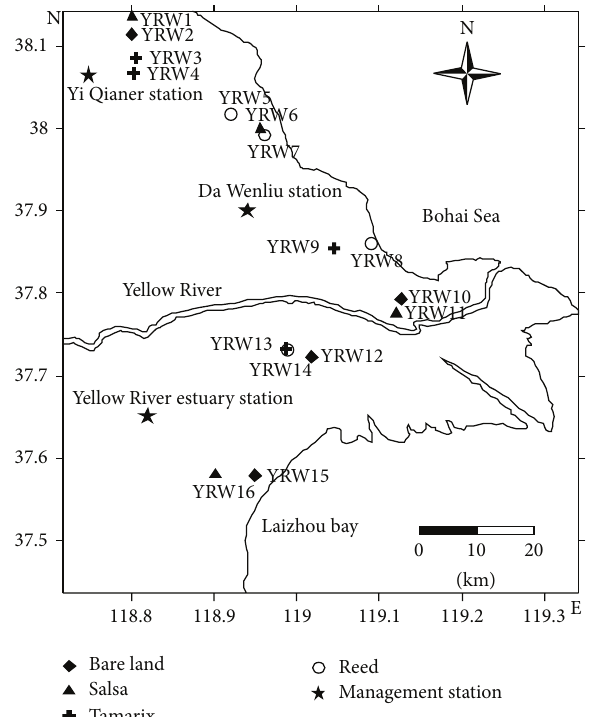
Figure 1: Location of studied region and sampling